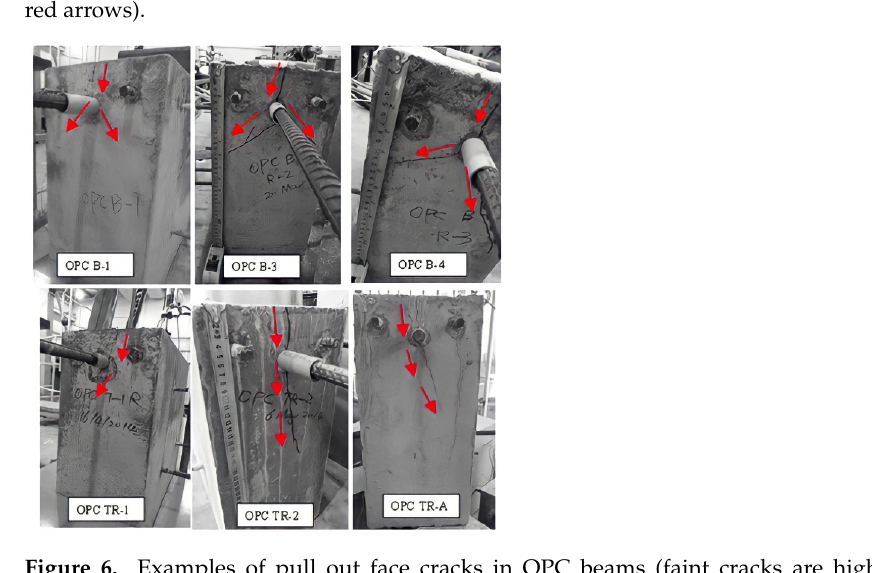
Figure 6. Examples of pull out face cracks in OPC beams (faint cracks are highlighted with red ar- rows).